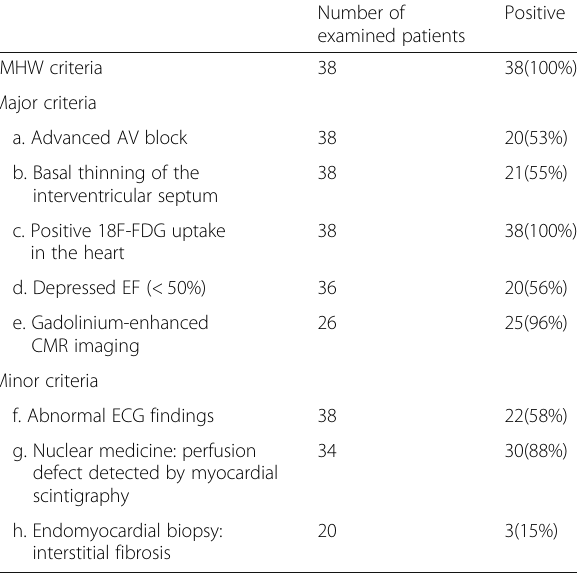
Table 1 Japanese Society of Sarcoidosis and Other Granulomatous Disorders (JSSOG) 2015 criteria for cardiac sarcoidosis